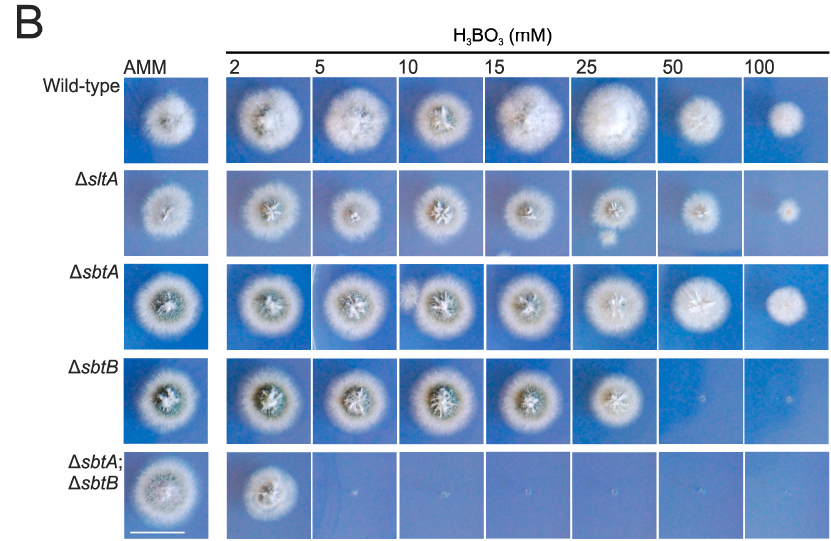
Figure 5. Tolerance of sbtA and sbtB deletion mutants to stress conditions induced by borates. Phenotype of wild-type, Δ sltA , Δ sbtA , Δ sbtB and ( Δ sbtA ; Δ sbtB ) after 48 h of culture at 37 °C in AMM with increasing concentration of Borax (1–15 mM) ( A ) or boric acid (2–100 mM) ( B ). Scale bar in both panels = 2 cm.